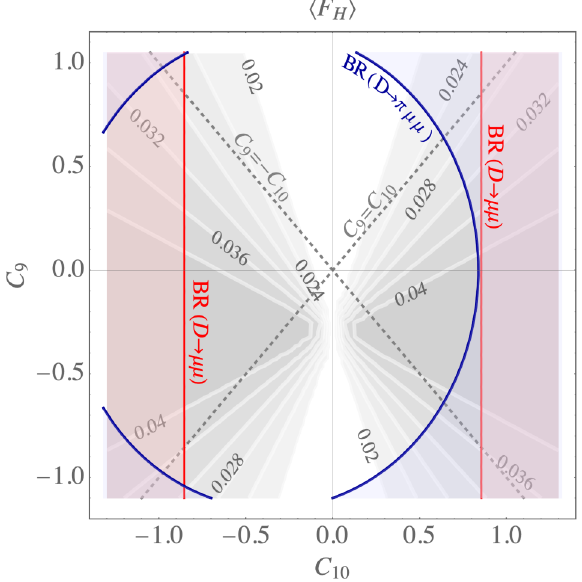
Figure 6 . Contours (white) of the observable h F H i , as defined in the text, in the C 10 – C 9 plane. The red lines and shaded areas indicate the exclusion from the LHCb bounds on the branching ratio B ( D 0 → µ + µ − ) [52], and for illustration the red dotted line shows the exclusion on increasing the bound by a factor three. The blue lines and shaded areas indicate the exclusion from the LHCb bounds on the branching ratio B ( D + → π + µ + µ − )